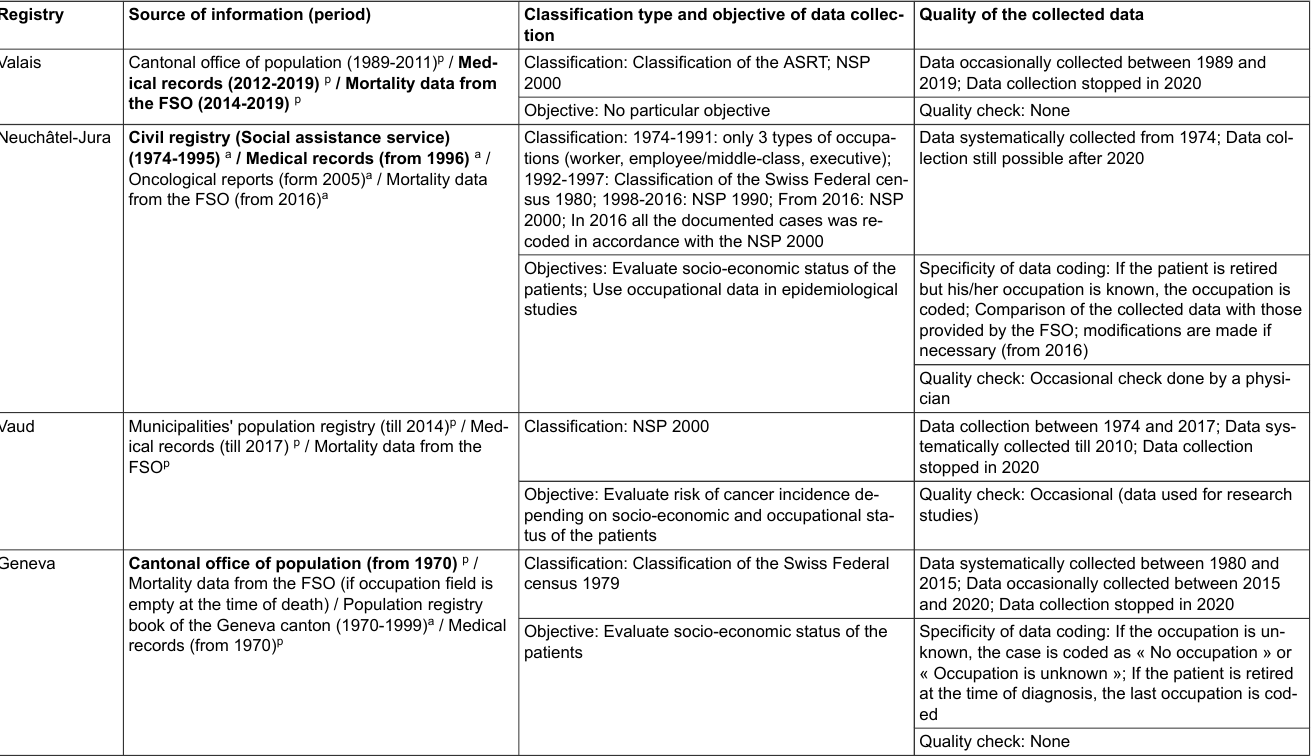
Quality of the collected tion